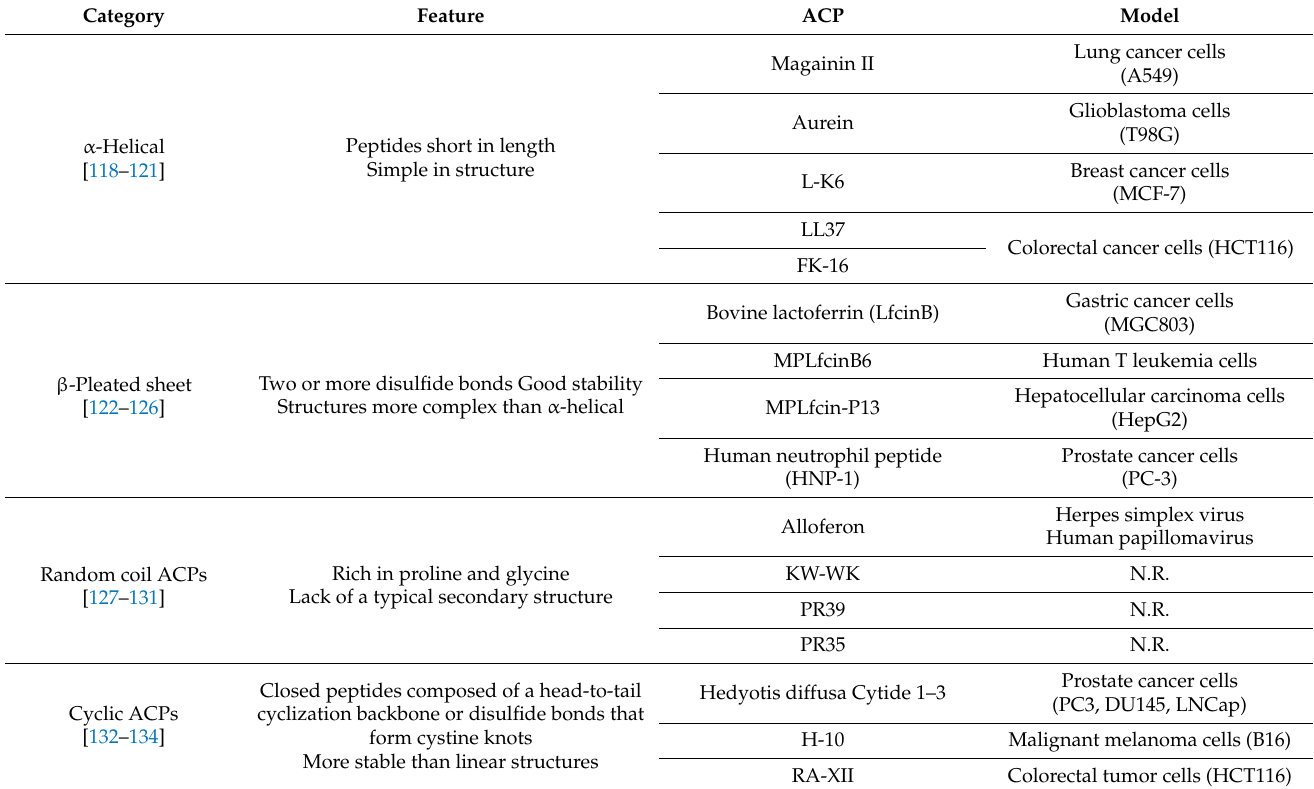
Table 1. ACPs showing antitumor and/or antiviral effects, classified according to their structural characteristics into four categories: α -helical, β -pleated sheets, random coil and cyclic [116,117].